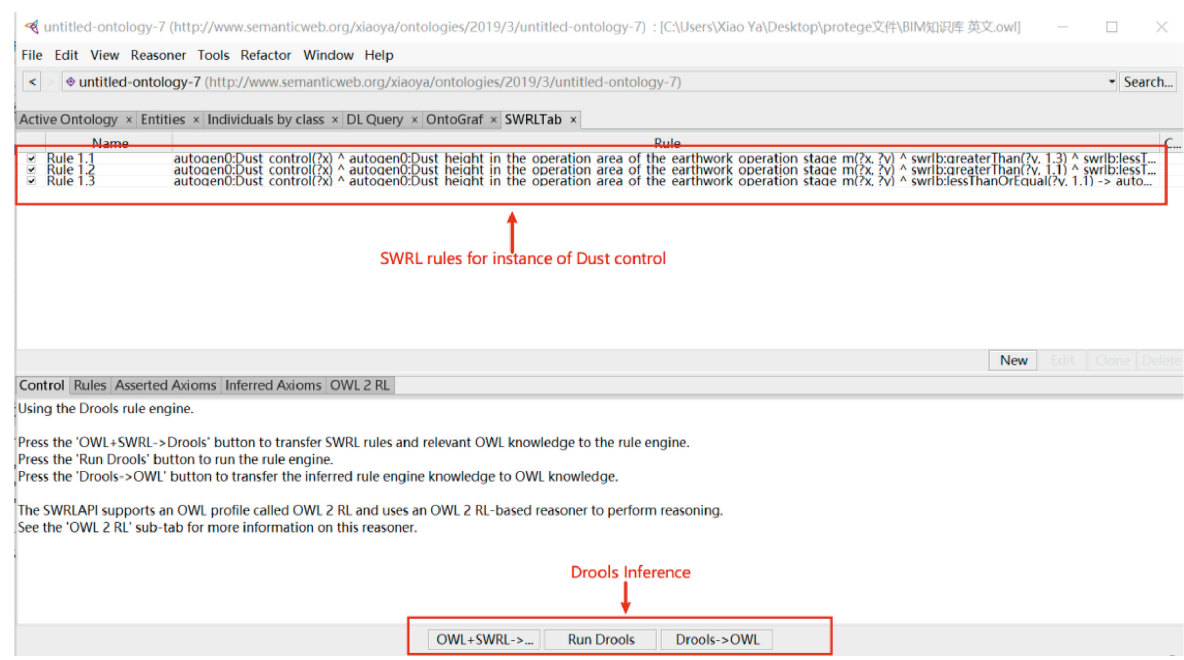
Figure 13: Induction instance of “dust